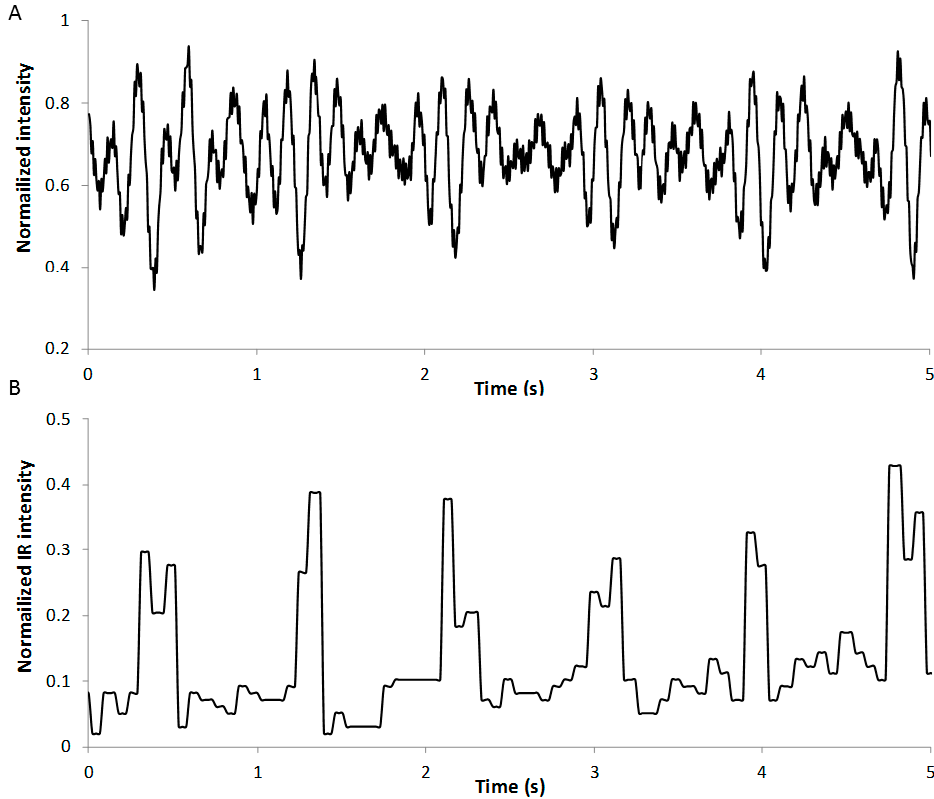
Figure 7. Comparison of BCG curves obtained with a PVDF sensor ( A ) and with the proposed optical sensor ( B ).